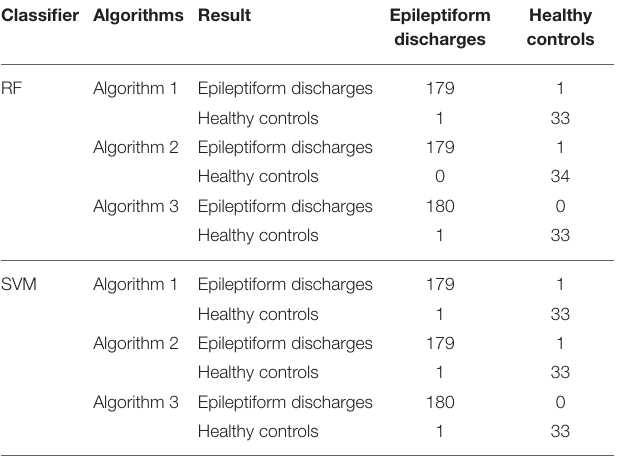
TABLE 2 | Confusion Matrix for the testing data of 180 epileptiform discharges and 34 normal controls: Algorithms 1, 2, 3 use PSD and λ ( ǫ 1 ), PSD and λ ( ǫ 2 ), PSD and λ ( ǫ ), respectively.